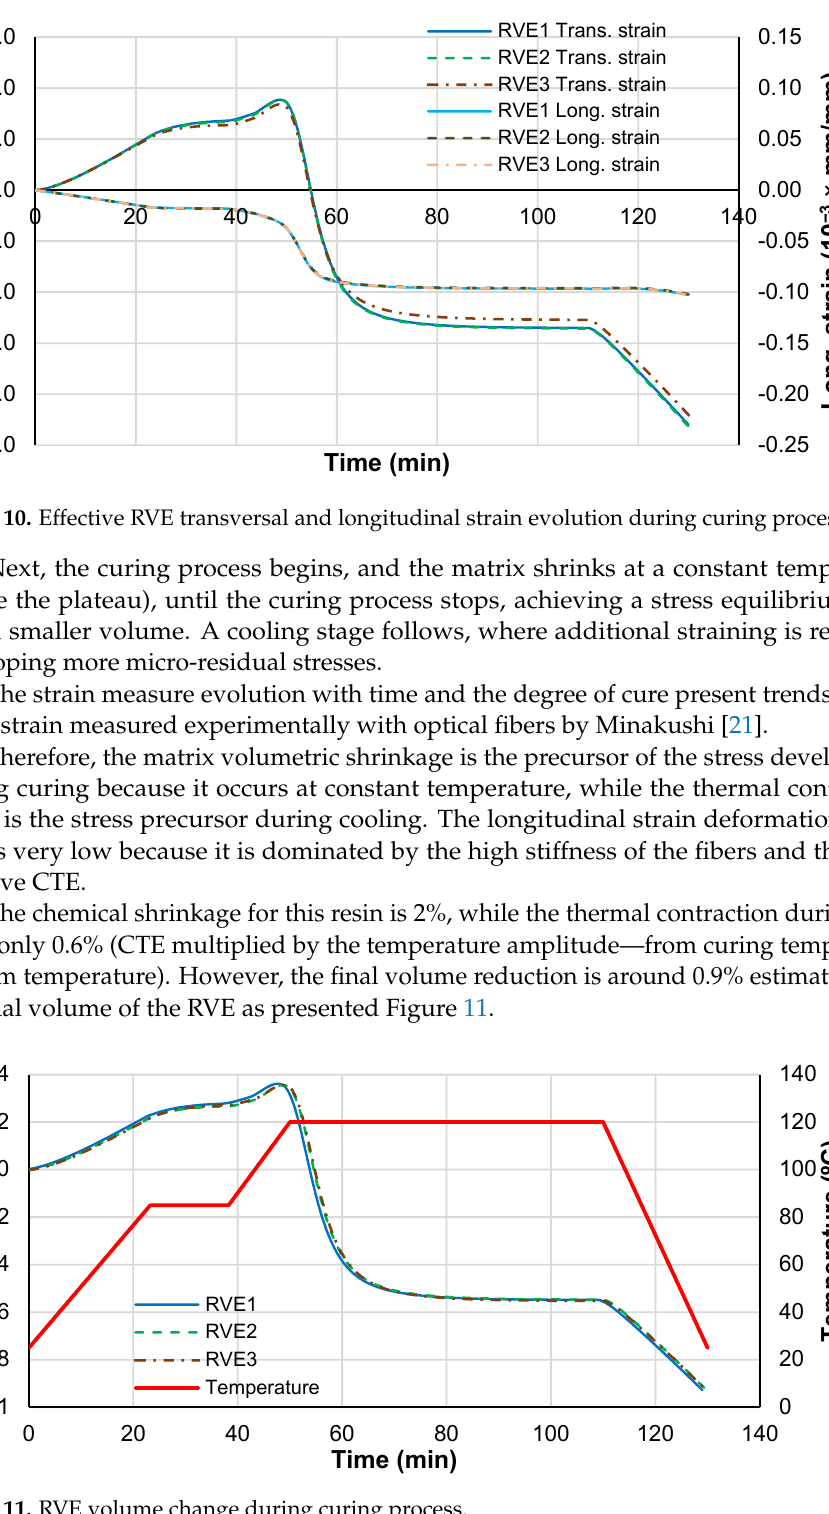
16 of 24 Figure 9. RVE average hydrostatic and von Mises stress evolution during the curing process. The strain measure evolution with time and the degree of cure present trends similar